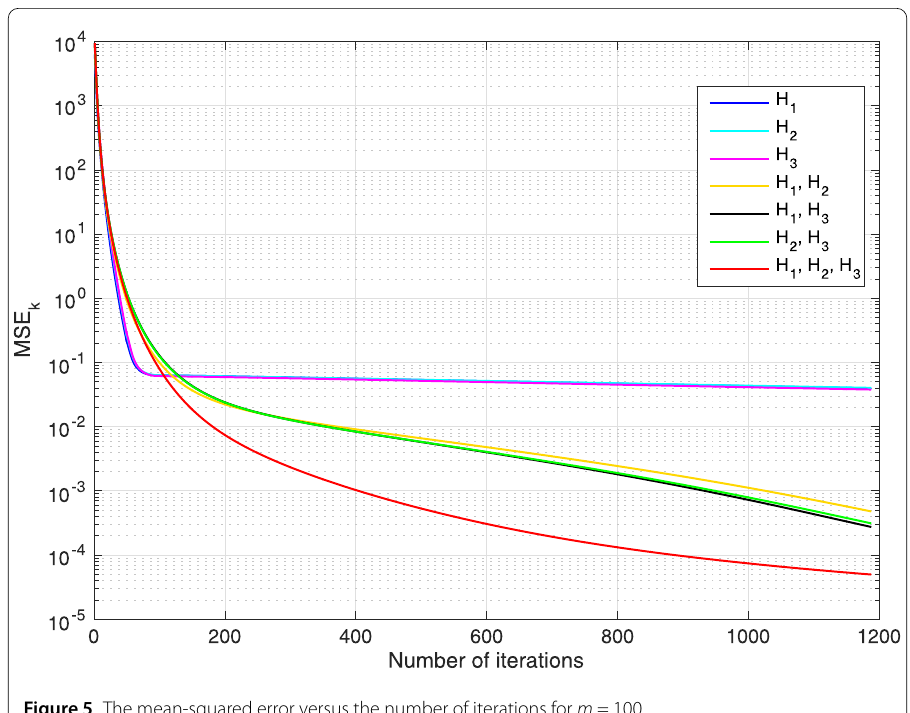
Figure 5 The mean-squared error versus the number of iterations for m = 100